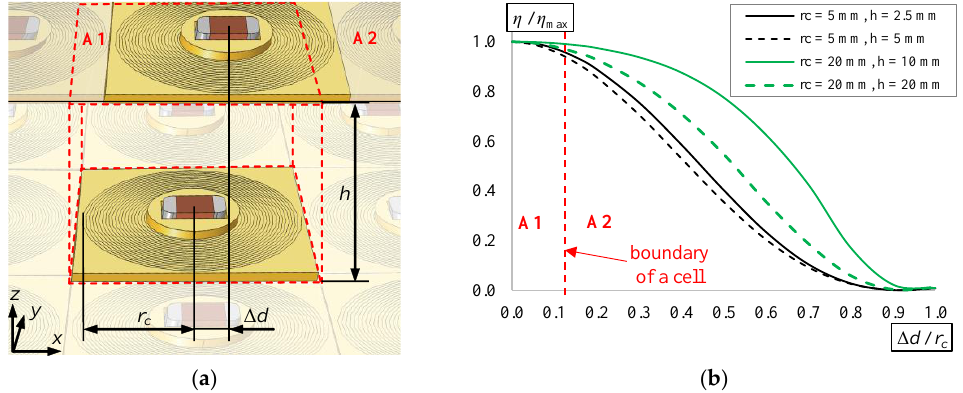
Figure 13. Horizontal misalignment in periodic WPT system: ( a ) visualization of horizontal distortion in WPT cell and ( b ) relative power transfer efficiency for different relative misalignment.